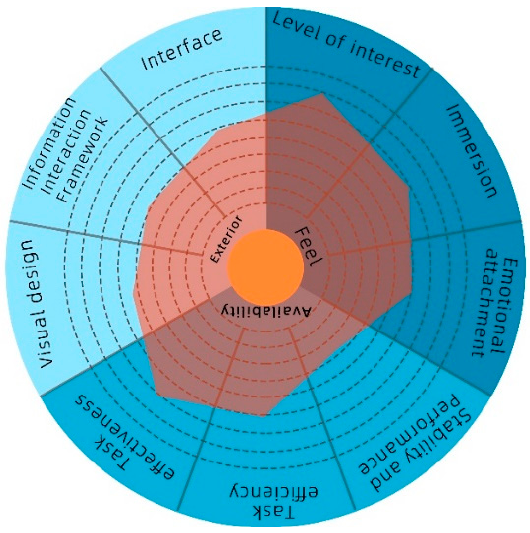
Figure 7. Radar scoring of the posttest evaluation.